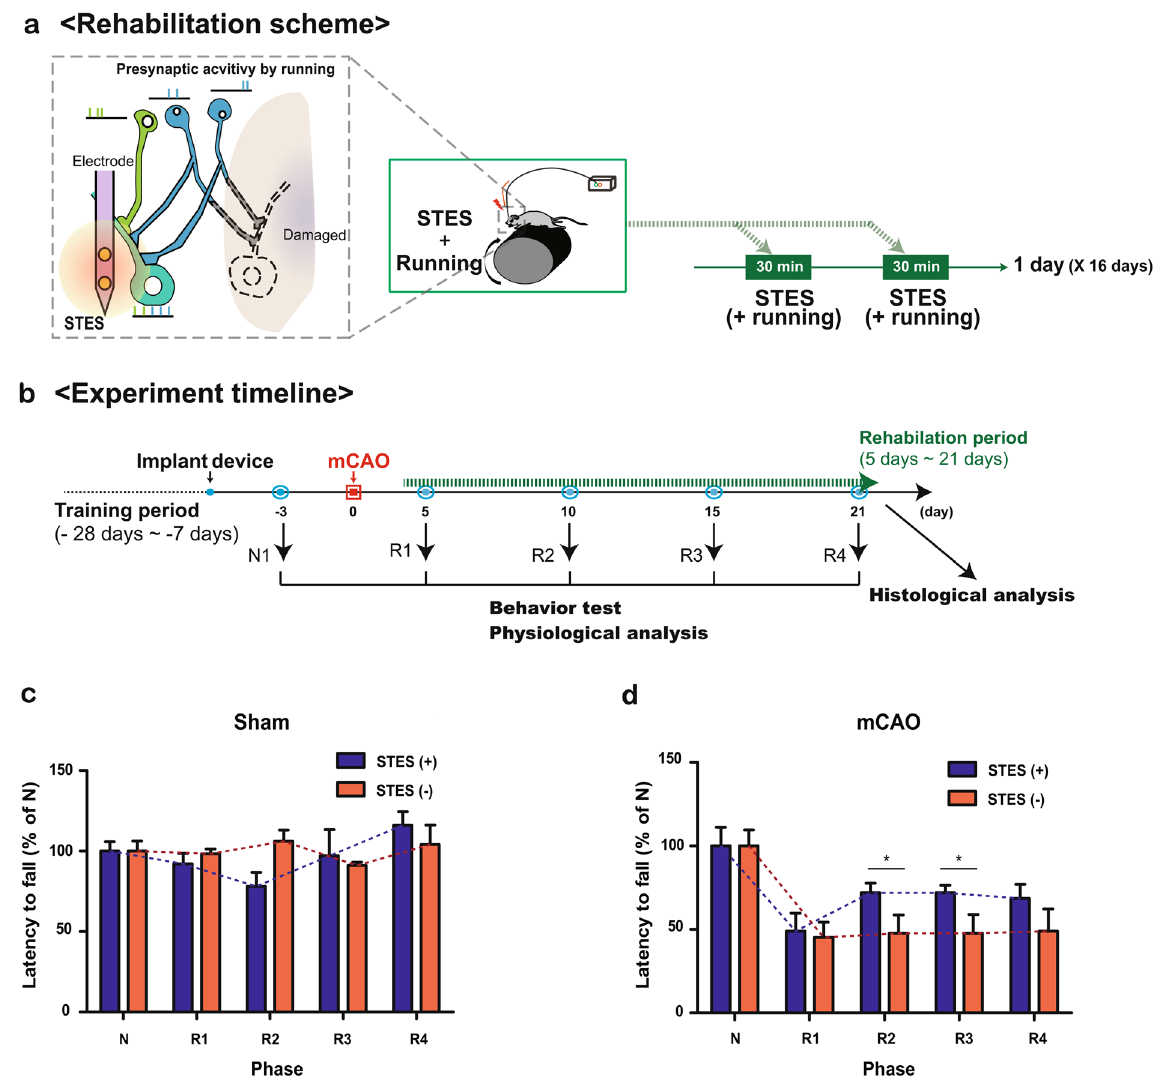
Figure 3. Overall experimental scheme and behavioral test analysis. ( a ) Rehabilitation scheme: STES was matched with rotarod training. The STES began at post-mCAO day 3 ~ 4, and the stimulation started at the same time as the running task for 30 min twice a day for 16 days. ( b ) Schematic of the rehabilitation timeline: the timeline shows the training period, mCAO, and rehabilitation period. After the training period (-28 days ~ -7 days), the device was implanted. Then, the pre-mCAO behavior and spike units were collected (N). mCAO surgery was performed at day 0, and the rehabilitation process (5 days ~ 21 days) began simultaneously with the collection of the post-mCAO behavior and spike units at post-mCAO day 5 (R1 ~ R4). After the rehabilitation process, all of the rats were sacrificed for histological analysis. Analysis of the latency to fall from the rotarod of ( c ) the sham (two-way ANOVA; interaction, ns; group, ns; phase, ns) and ( d ) mCAO animals with or without STES (two-way ANOVA; interaction, ns; group, * p < 0. 05, F(1,70) = 11.1; phase, *** p < 0.0001, F(4,70) = 17.62). More than 4 animals were monitored for each condition (n = 4, sham STES(-); n = 4, sham STES( +); n = 5, mCAO STES(−) and n = 8, mCAO STES(